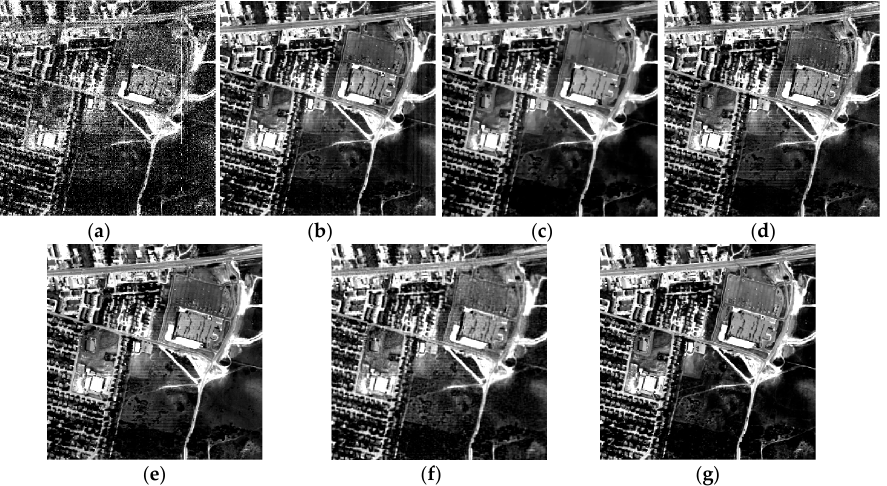
Figure 7. Denoised results by different methods of the 206 th band in an urban dataset: ( a ) original, ( b ) HyRes, ( c ) LRTV, ( d ) LRMR, ( e ) NAILRMA, ( f ) LRTDTV, and ( g ) proposed.